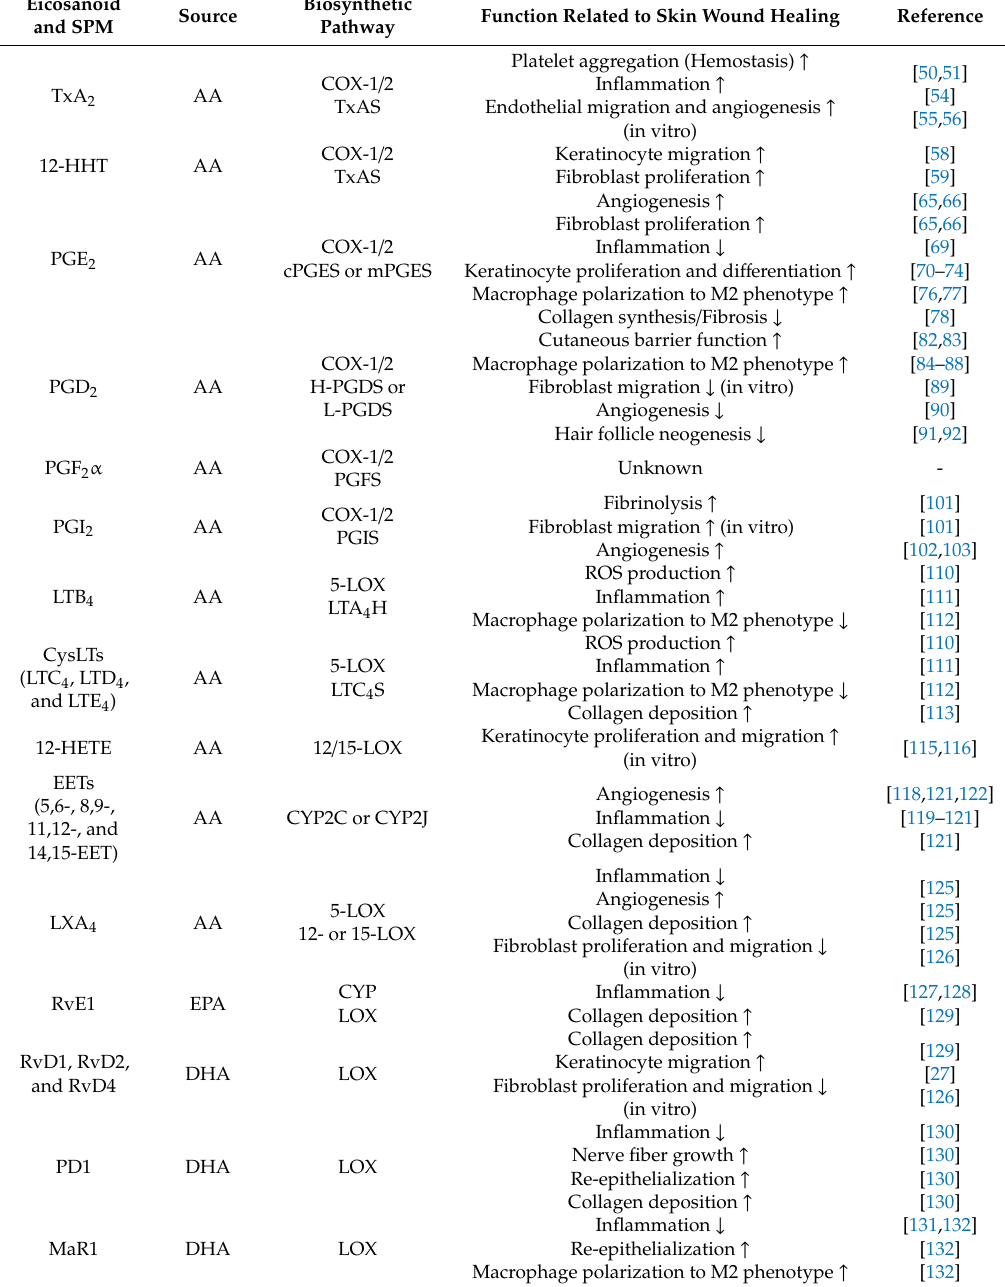
Table 1. Overview of eicosanoids and SPMs involved in skin wound